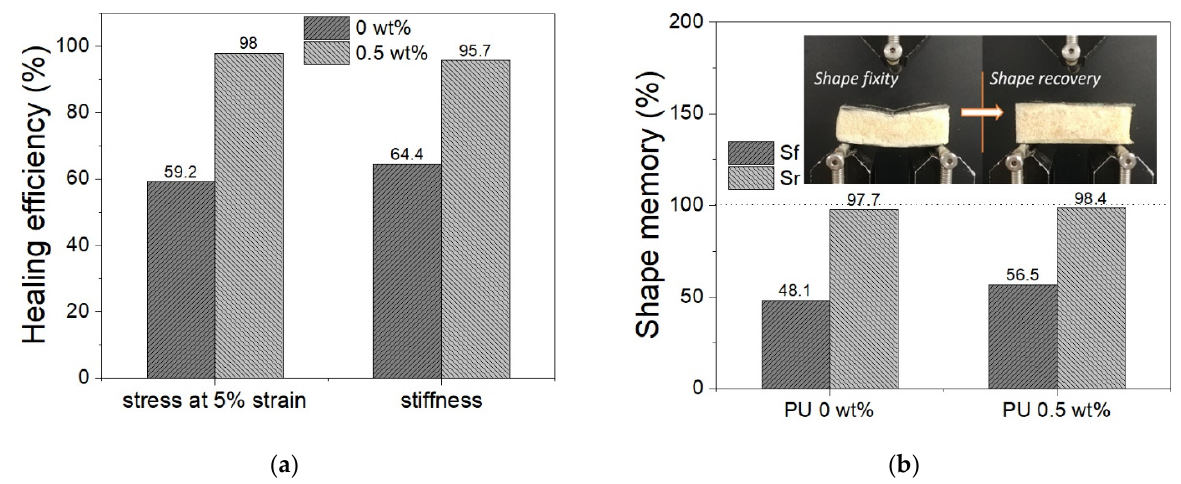
Figure 12. Load–displacement ( a ) and stress–strain ( b ) curves of SM sandwiches at initial state and after recovery.